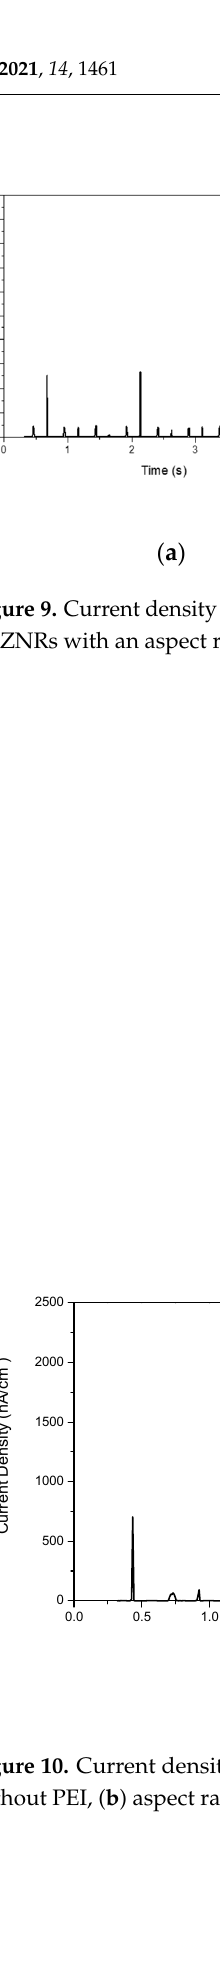
Figure 9. Current density generated from piezoelectric NGs with PDMS layers of various thickness, ( a ) 40, ( b ) 80, ( c ) 100 μ m, on ZNRs with an aspect ratio of 11:1. Table 3. Current density generated from piezoelectric NGs with various thicknesses of PDMS, (a)